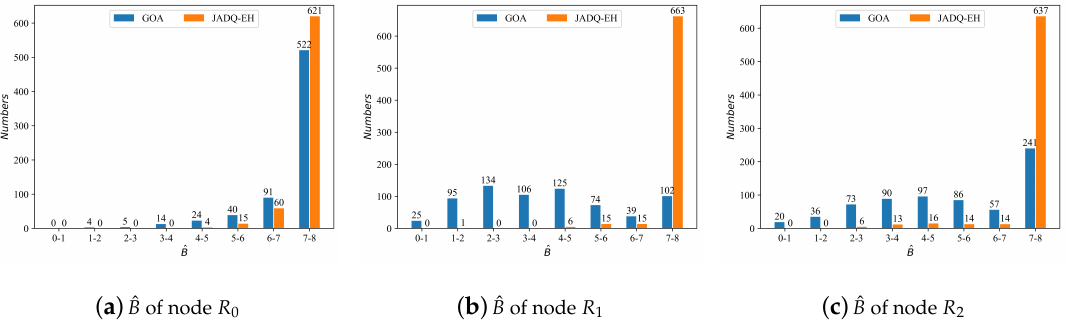
Figure 12. ˆ B of each node comparison between Greedy optimal joint resources allocation (GOA) and JADQ-EH under scenario